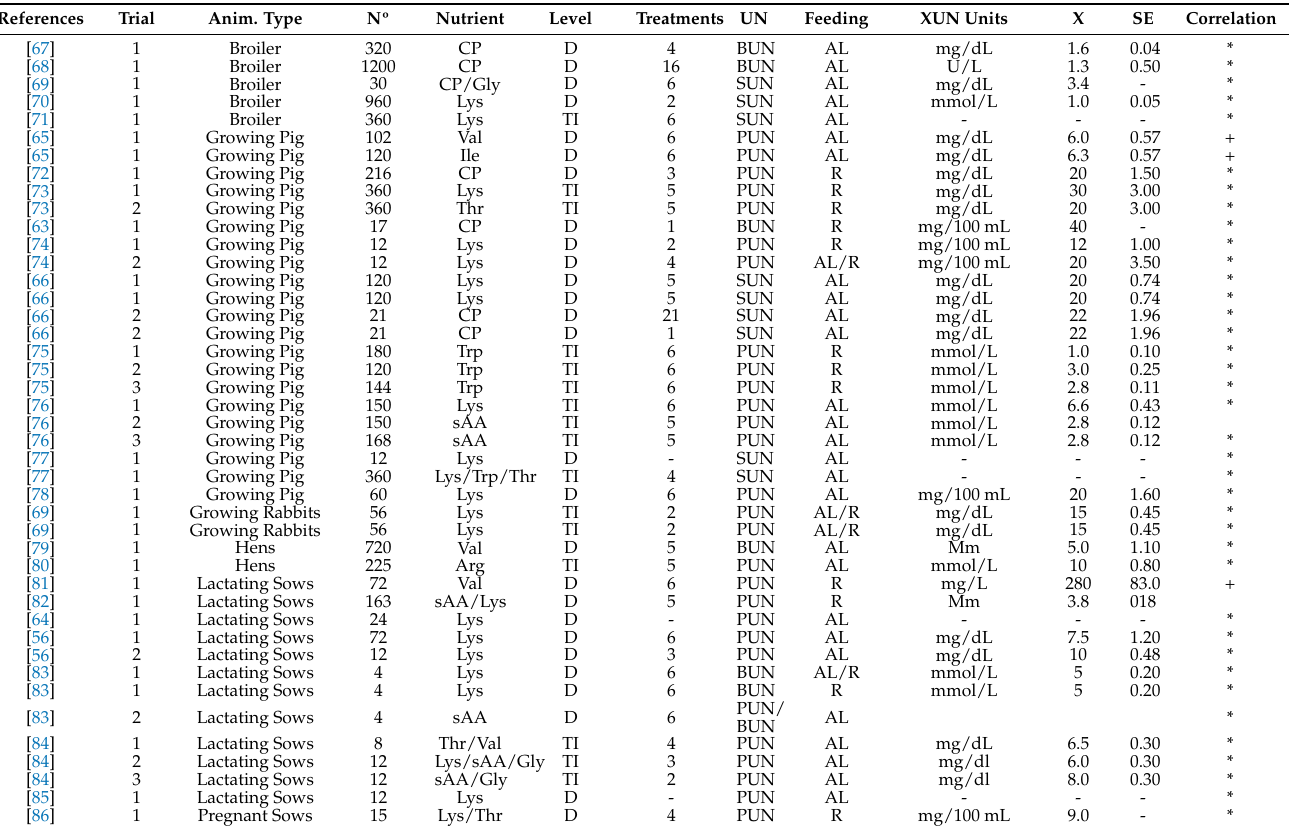
Table 1. Parameters studied in the published works where urea nitrogen (UN) is used to determine nutritional requirements in monogastrics and related with performance and reproductive